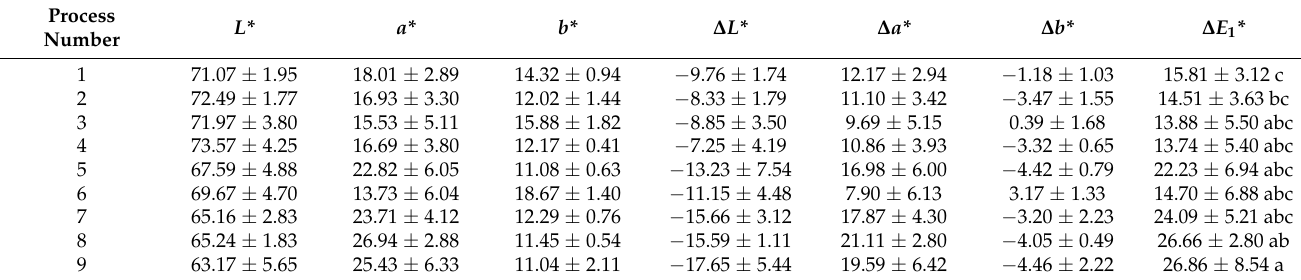
Table 2. Color difference indexes of red-heart Chinese fir wood with different dyeing